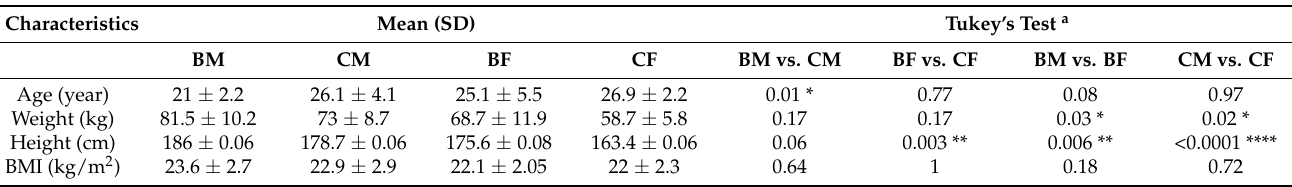
Table 1. Participants’